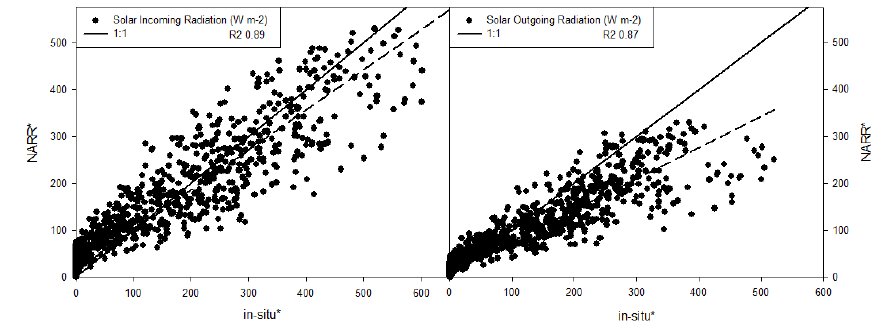
Figure 4. Incoming and outgoing shortwave radiation for the 2010 site for proxy comparison (denoted by ∗